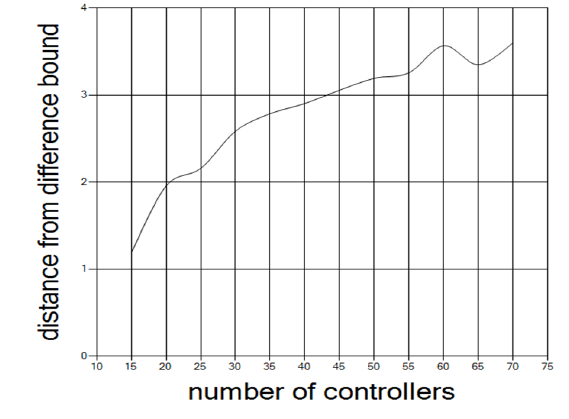
Figure 7. Distance between the difference bound and actual difference.